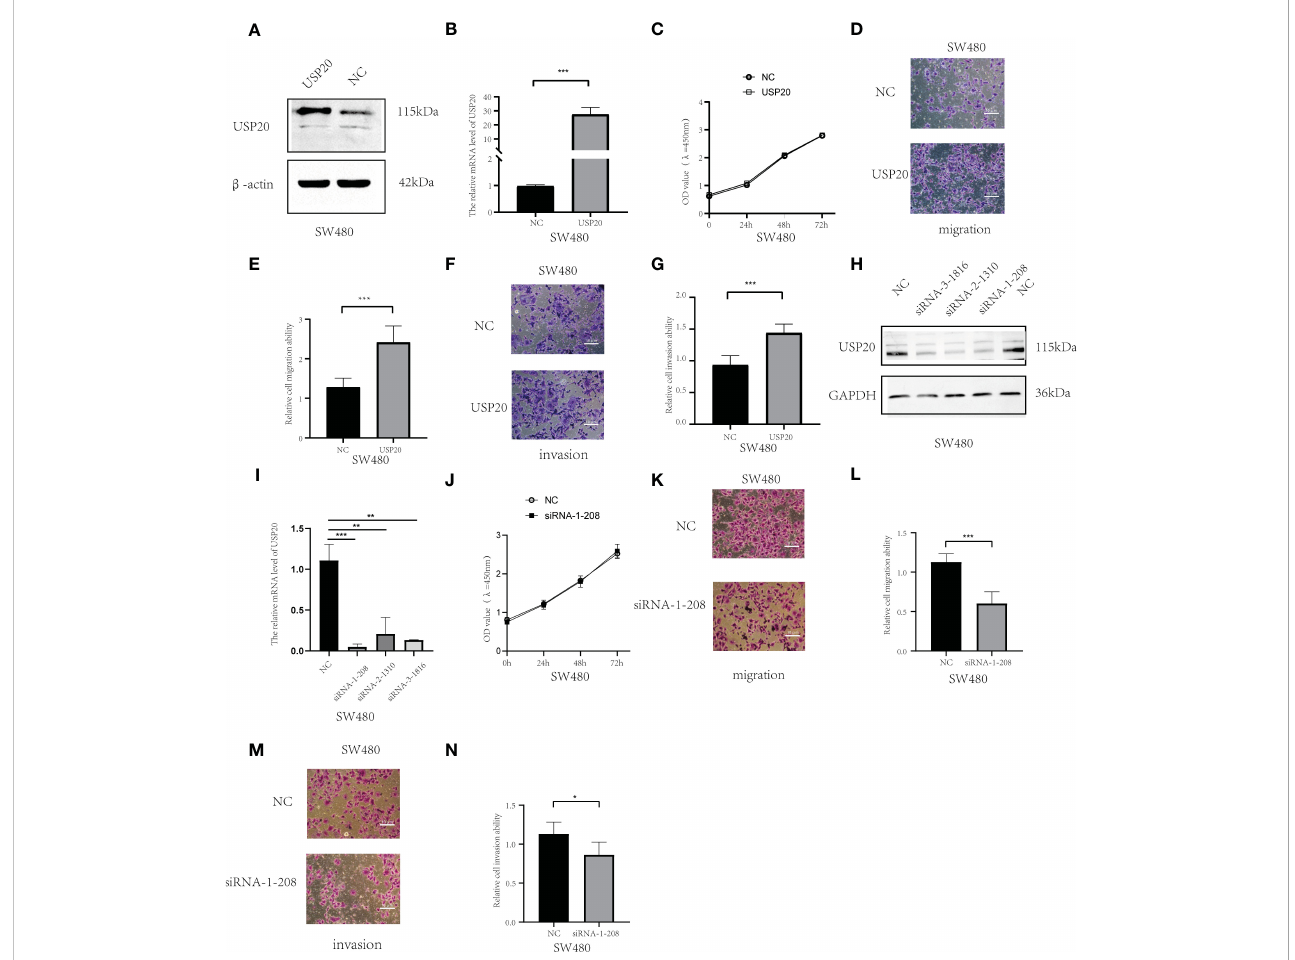
FIGURE 8 USP20 promotes the metastasis of CRC cells; (A) USP20 Plasmid transfection ef fi ciency was determined by Western blots. (B) ; USP20 Plasmid transfection ef fi ciency was determined by qRT-PCR. (C) The CCK-8 results showed that the overexpression of USP20 displayed no obvious effects in cell proliferation of SW480. (D – G) Overexpression of USP20 enhanced CRC cell migration and invasion abilities were demonstrated via Transwell migration assays and Transwell invasion assays. (H) Western blots showing knockdown ef fi ciency of the siRNAs. (I) The ef fi ciency of siRNAs was veri fi ed by qRT- PCR. (J) The CCK-8 results showed that the knockdown of USP20 displayed no obvious effects in cell proliferation of SW480. (K – N) Knowdown of USP20 decreased CRC cell migration and invasion abilities were demonstrated via Transwell migration assays and Transwell invasion assays. (*P < 0.05; **P < 0.01; ***P < 0.001; NS, not signi fi